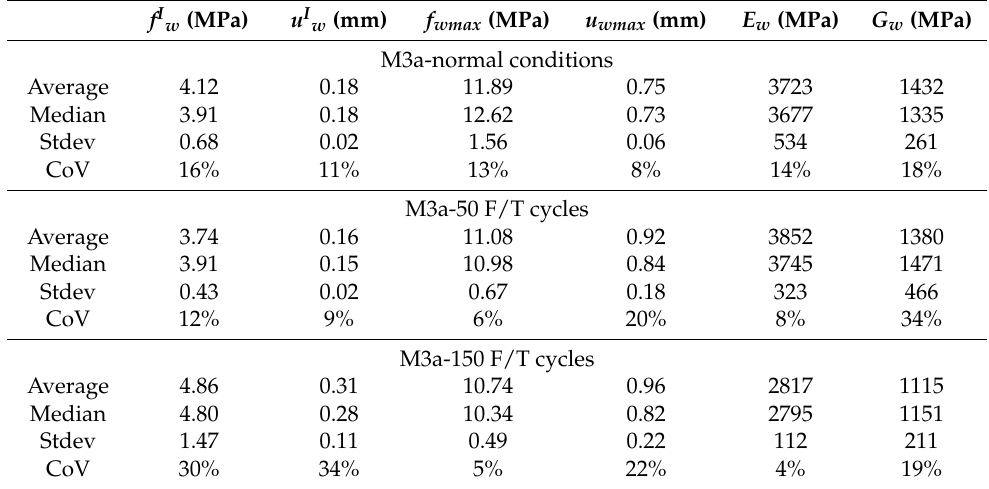
Table 2. Results of the compressive tests of the wallets M3a